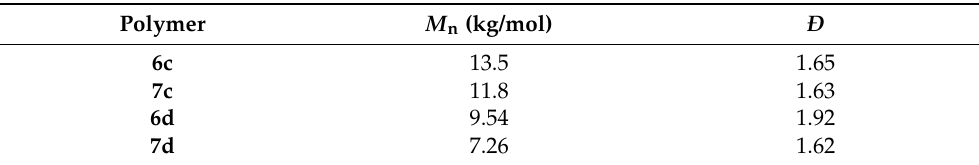
Table 1. Number average molecular weight ( M n ) and dispersity ( Ð ) of the copolymers obtained, determined by SEC in tetrahydrofuran (THF).